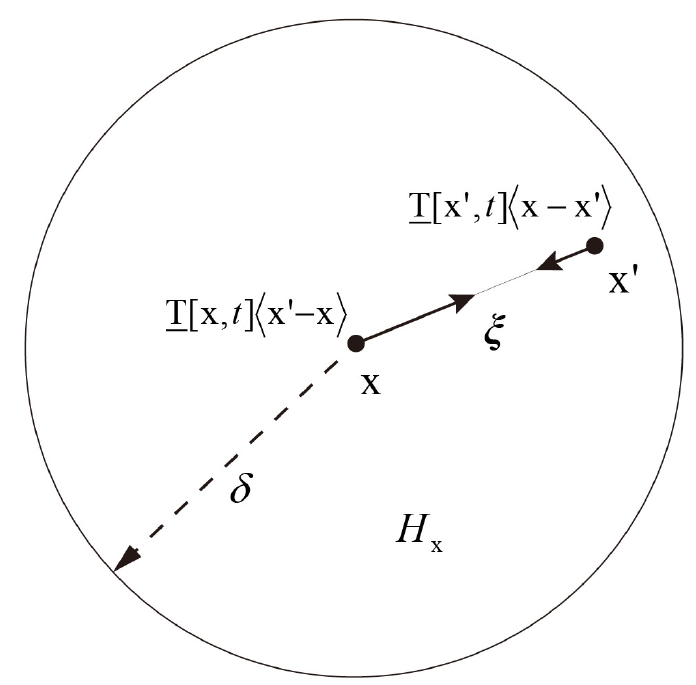
Figure 1. OSB-PD